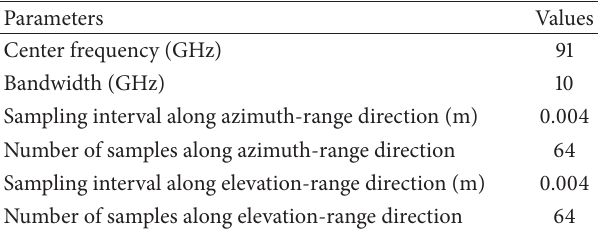
Table 1: Simulation parameters for full set of